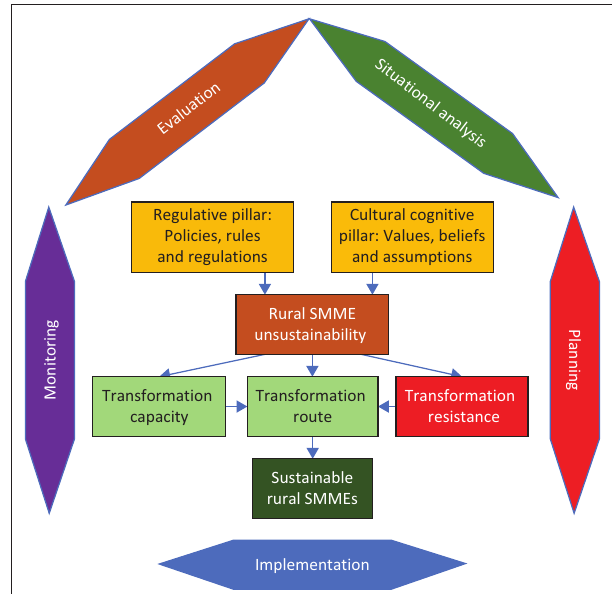
FIGURE 4: Proposed rural SMME policy implementation